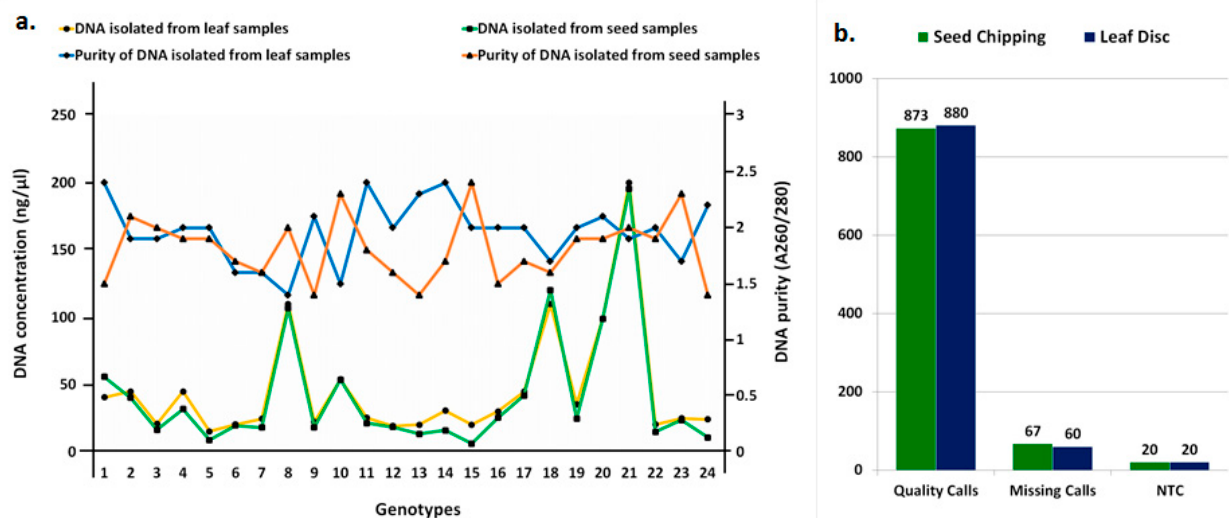
Figure 3. Comparative assessment of DNA quantity, quality and quality genotyping calls achieved from leaf disc and seed-chipping samples during genotyping. ( a ) Comparison of DNA quality and quantity between seed chipping and leaf disc samples, ( b ) Comparison of SNP calls between seed chipping and leaf disc samples.